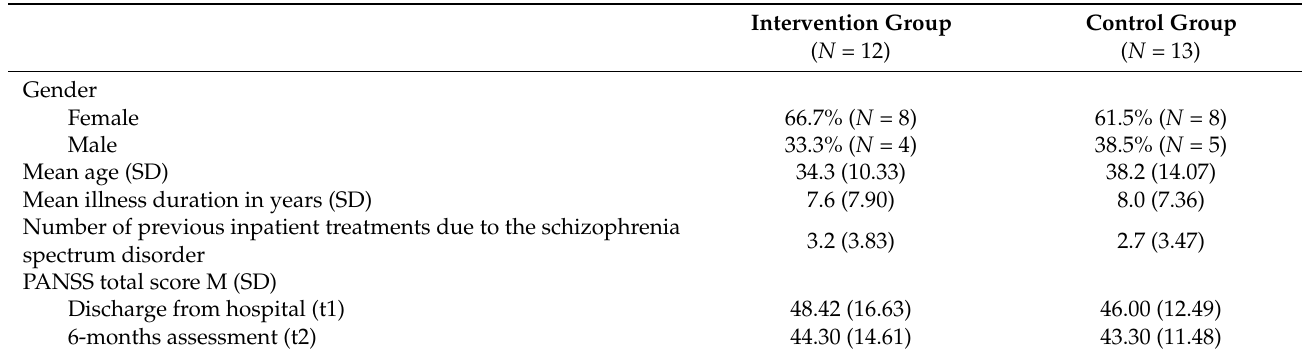
Table 1. Demographic characteristics and clinical variables.